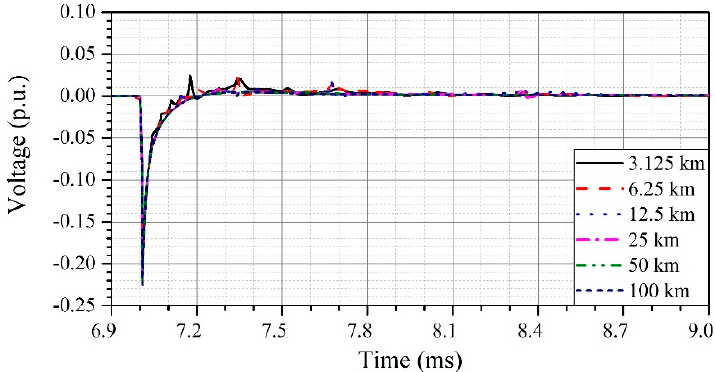
Figure 12. Sheath-ground overvoltage at the sending end terminal of the cables considering different cable lengths.